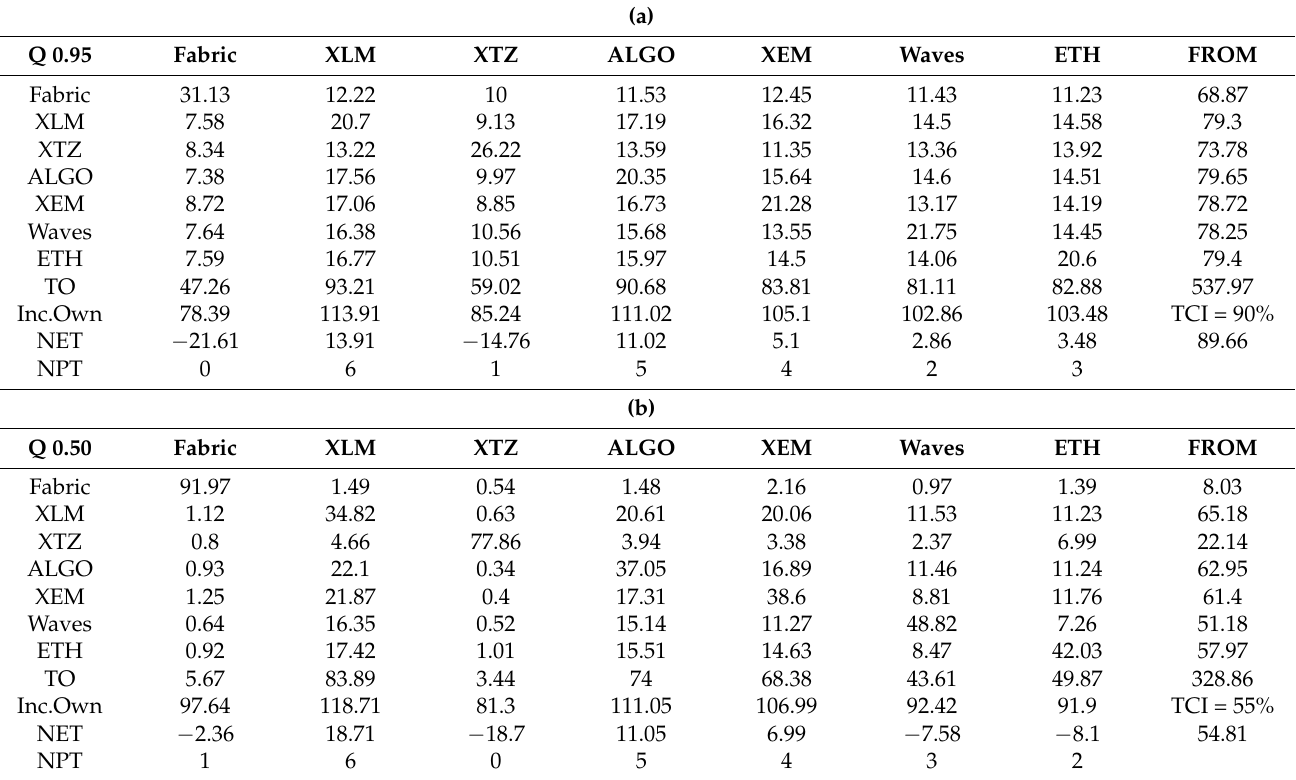
Table 2. Average quantile connectedness depicting the shock emitters and receivers (refer to the note below).